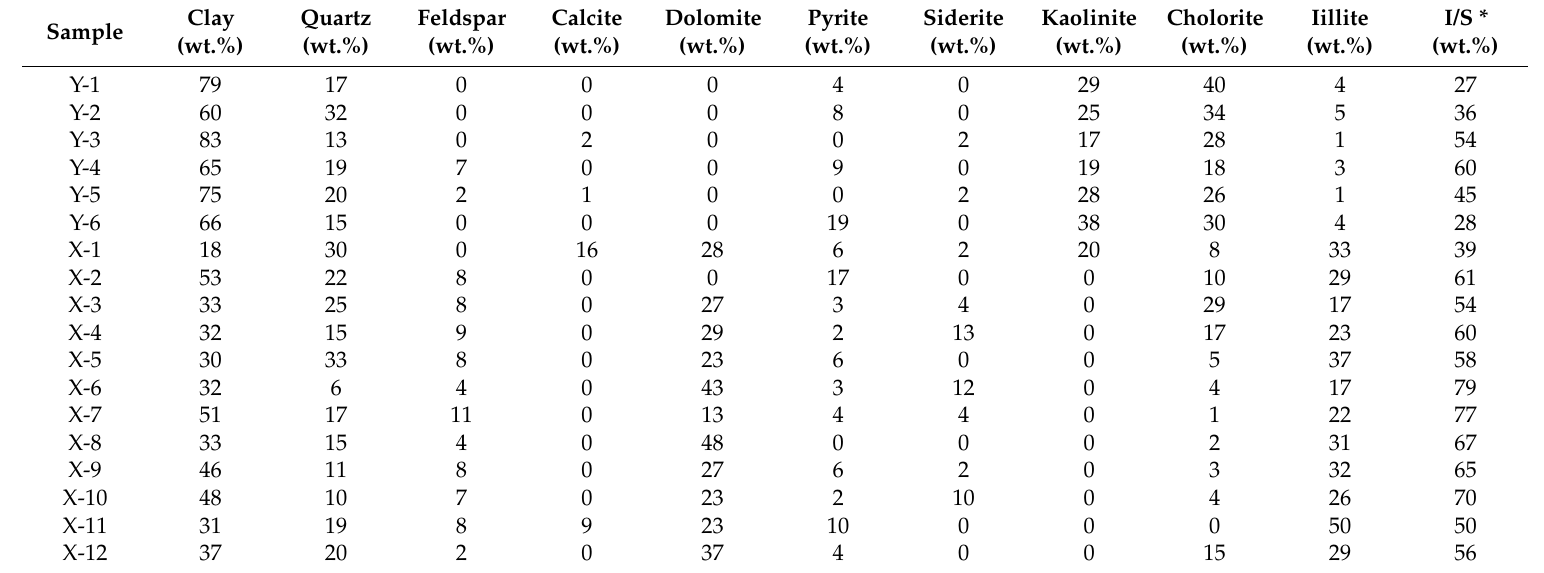
Table 3. Mineralogy composition of transitional Longtan Shale samples from YV-1 and